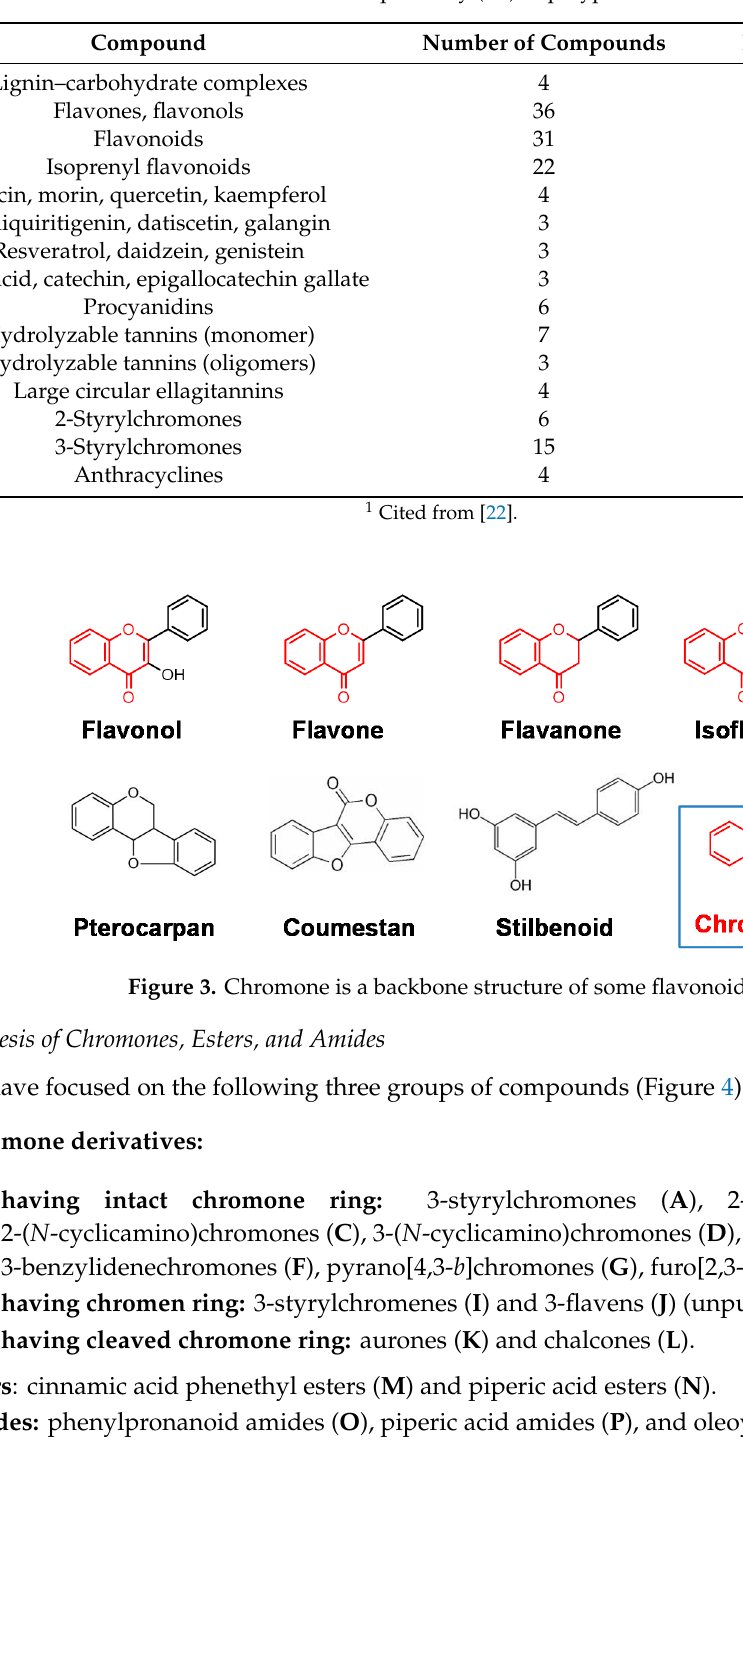
Table 3. Tumor specificity (TS) of polyphenols.